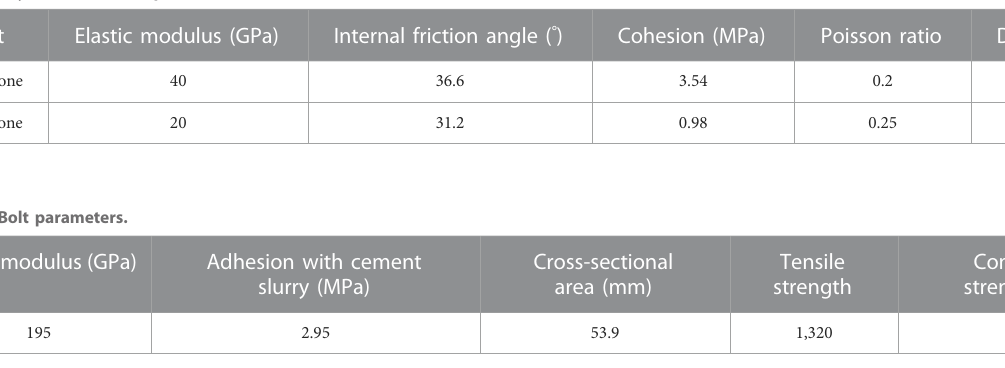
TABLE 3 Physical mechanics parameters.